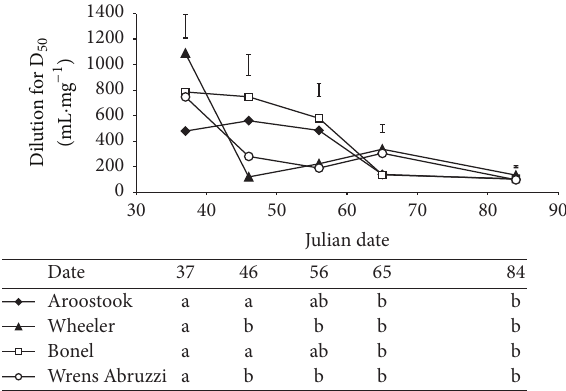
Figure 1: Inhibition of pigweed germination and growth by extracts of four field grown rye varieties, harvested at five different dates (Julian dates) during the spring of the first year of experiments. D 50 is the concentration required to cause 50% growth inhibition. Significantdifferencesovertimewithineachvarietyaccordingtothe Tukey-Kramer method ( 𝑝 < 0.05 ) are indicated by different letters. Vertical bars represent standard errors at each sampling